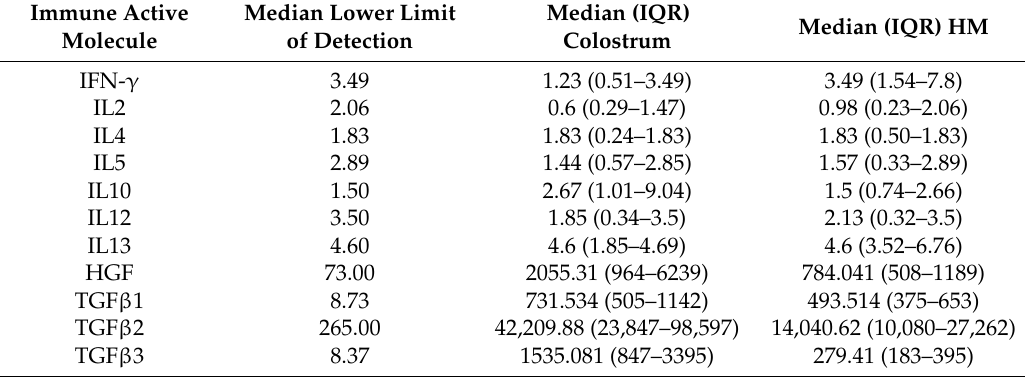
Table A1. Lower limit of detection values (pg/mL) for cytokines and growth factors analysis and overall locations median concentrations for all immune active molecules (values below LLOD for all cytokines have been transformed into 1 / 2 of LLOD).